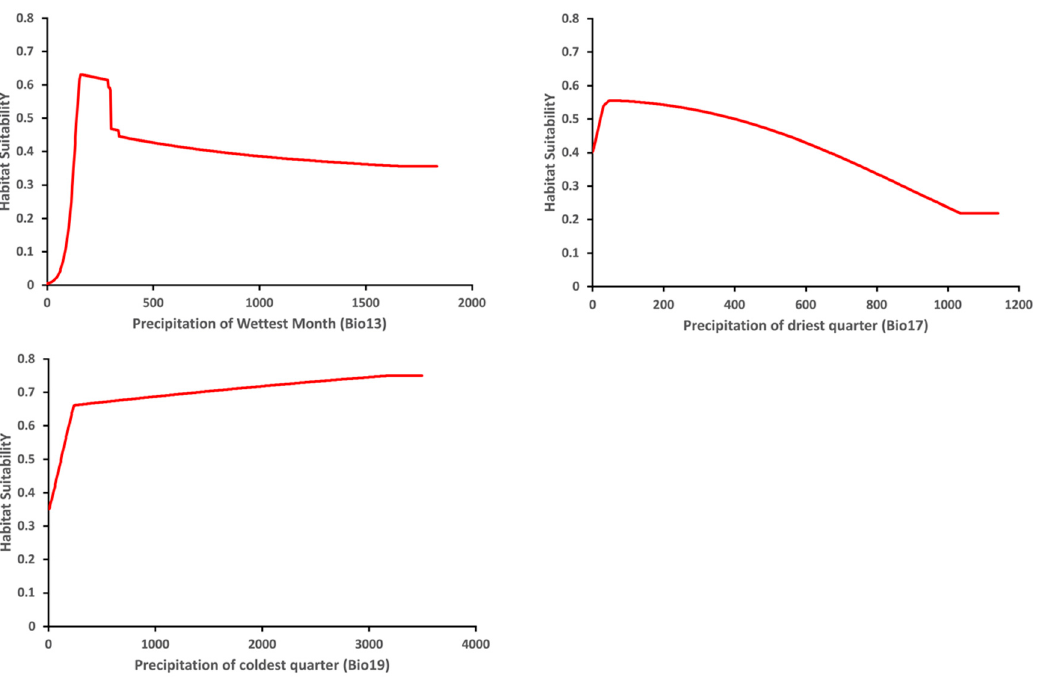
Figure 7. Relationship of habitat suitability response for Thaumatotibia leucotreta to three environmental variables (Bio13, Bio17, Bio19) (Units: Precipitation mm).